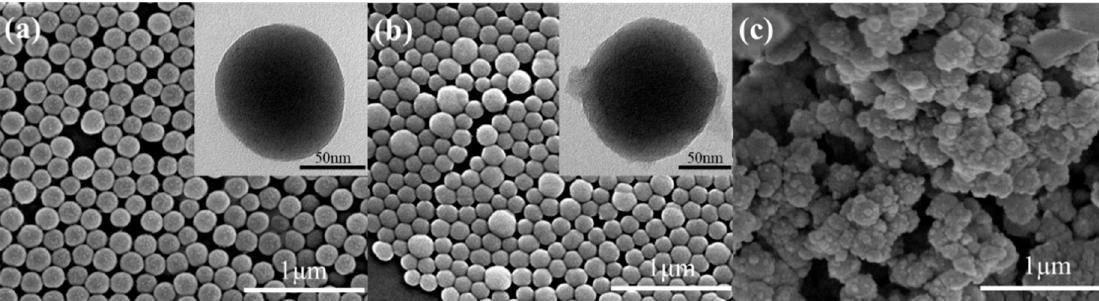
Figure 3. SEM and TEM images of the pristine and methylated silicas: ( a ) pristine silica, ( b ) methylated silica, and ( c ) methylated silica coating.